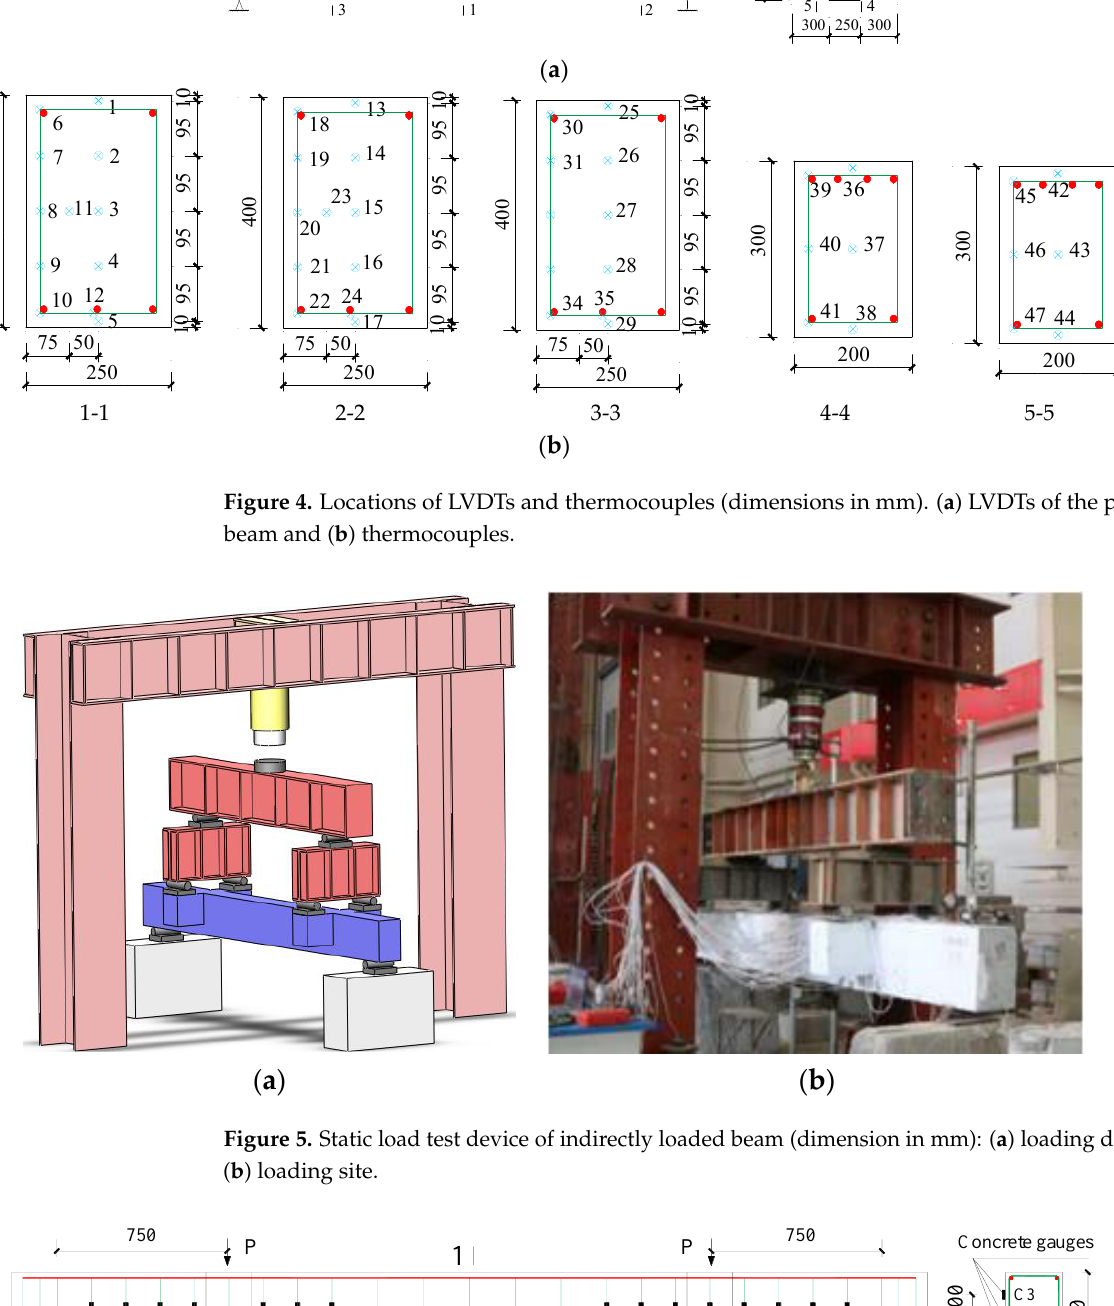
Figure 4. Locations of LVDTs and thermocouples (dimensions in mm). ( a ) LVDTs of the preloaded beam and ( b ) thermocouples.